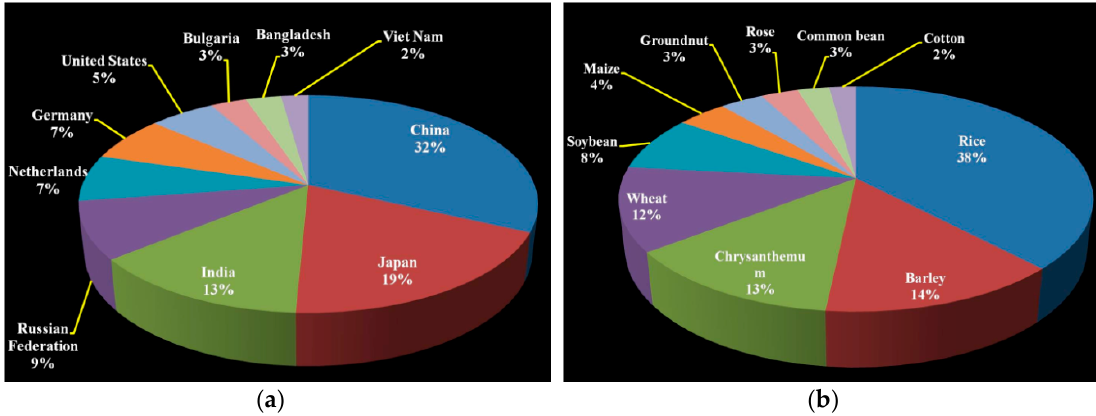
Figure 1. ( a )Pie chart representing the percentage contribution of top ten countries for crop mutant variety development. ( b )Pie chart representing the percentage contribution of the top ten officially registered mutant crop species. Common name of the crop is used for grouping purpose. Data came from FAO/IAEA Mutant Variety Database [39].